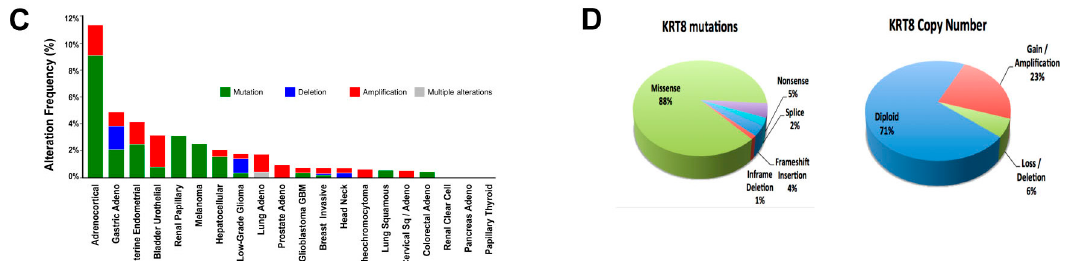
Figure 1. Keratin-8 (KRT8) genetic alterations are common in epithelial cancers. ( A ) KRT8 expression by RNAseq for cancer versus normal in >3000 cases across 15 epithelial cancer types. Six cancer types showed a >2-fold increase in KRT8 expression in cancer compared to normal, while the opposite was true for three cancer types; ( B ) KRT8 expression plotted individually as dot-plots within each tumor type shows a population subset with elevated KRT8 expression in most tumor types; ( C ) Genomic data from >5000 cancer patients were examined for KRT8 alterations at the DNA level, which were present in up to 11% of cases depending on tumor type; ( D ) Among mutations, the majority were missense mutations (88%), while nonsense and deletion mutations were uncommon. Similarly, most copy number variations were due to amplification, and gene loss was less frequent.